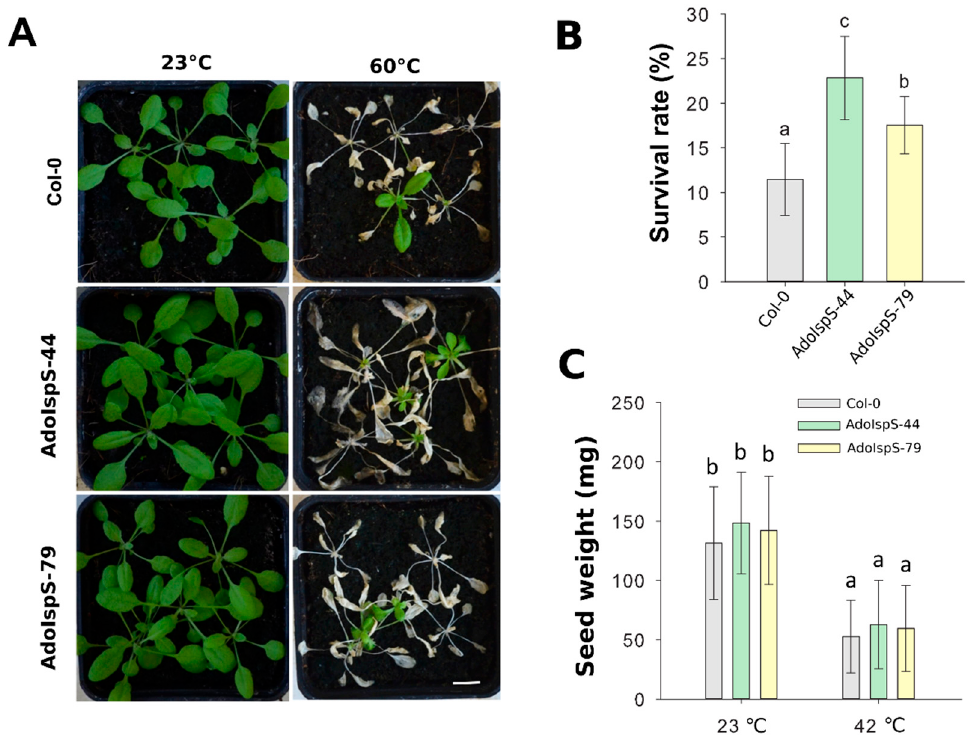
Figure 9. Thermal tolerance of Col-0 and IspS plants grown hydroponically. ( A ) Thermal tolerance of Col-0 and IspS transgenic plants grown in hydroponic medium. Three week old plants were treated with heat shock, representative images were taken (Scale bar = 1 cm) ( A ), and the percentages of surviving plants ( B ) were measured after 1 week of recovery. ( C ) Total weight of seeds produced per plant in Col-0 and IspS lines under normal growth and heat-shock condition. Histogram bars marked with the same letter do not significantly differ from each other (Tukey–Kramer test, p > 0.05). Line bars represent the SD of the means.